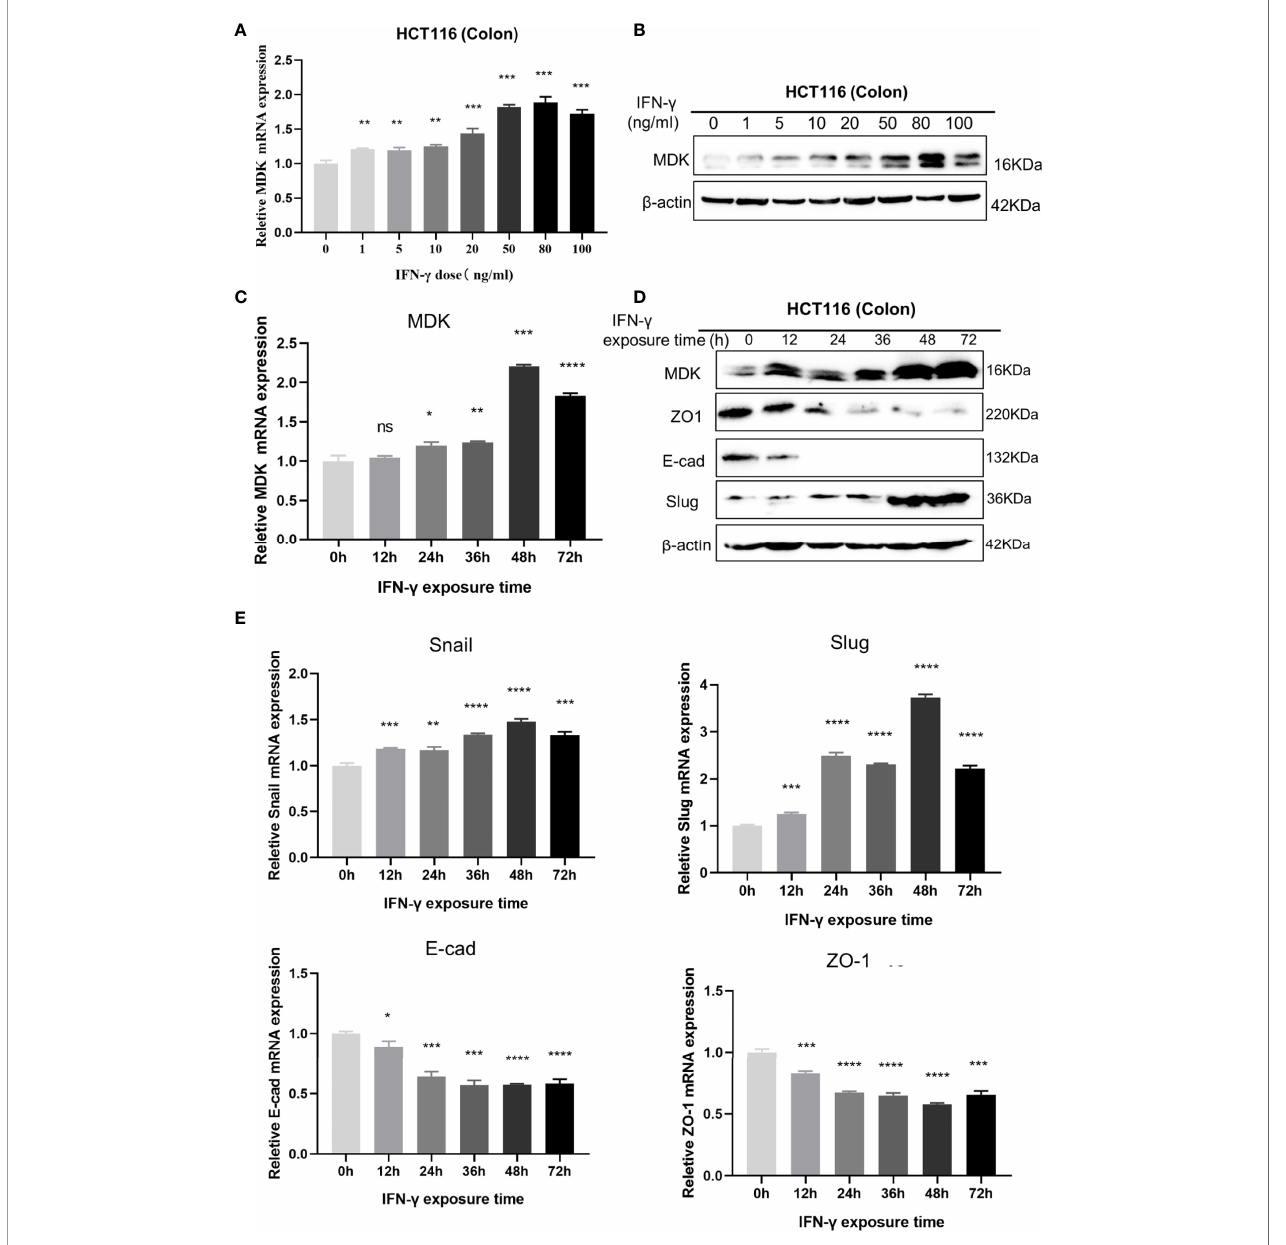
FIGURE 3 | Dose- and time-dependent effects of IFN- g on MDK induction. (A) RT-qPCR assays to examine the effect of IFN- g concentration on MDK induction in the HCT116 cell line. (B) Western blotting assays to examine the effect of IFN- g concentration on MDK induction in the HCT116 cell line. (C) RT-qPCR assays to examine the effect of IFN- g treatment time on MDK induction in the HCT116 cell line. (D) Western blotting assays to examine the effect of IFN- g treatment time on MDK induction and EMT activation in the HCT116 cell line. (E) RT-qPCR assays showing the effect of IFN- g treatment time on EMT markers in the HCT116 cell line. *P < 0.05, **P < 0.01, ***P < 0.001, ****P < 0.0001. ns, not signi fi